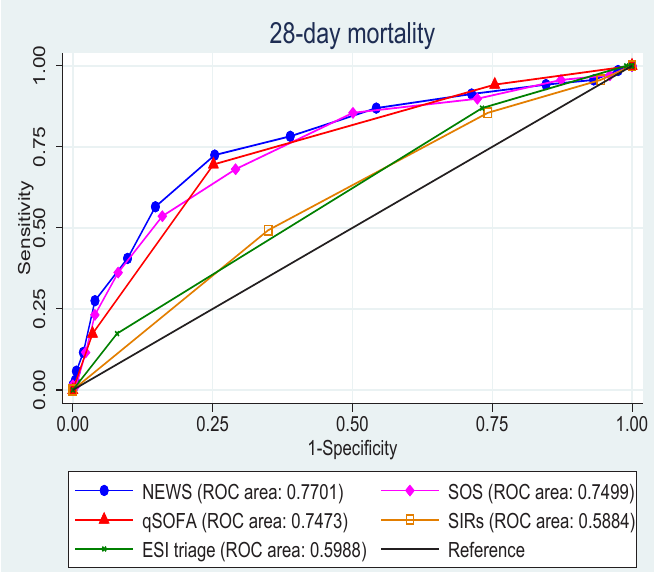
Figure 2. The AUROC of the predictive scores for predicting 28- day mortality.